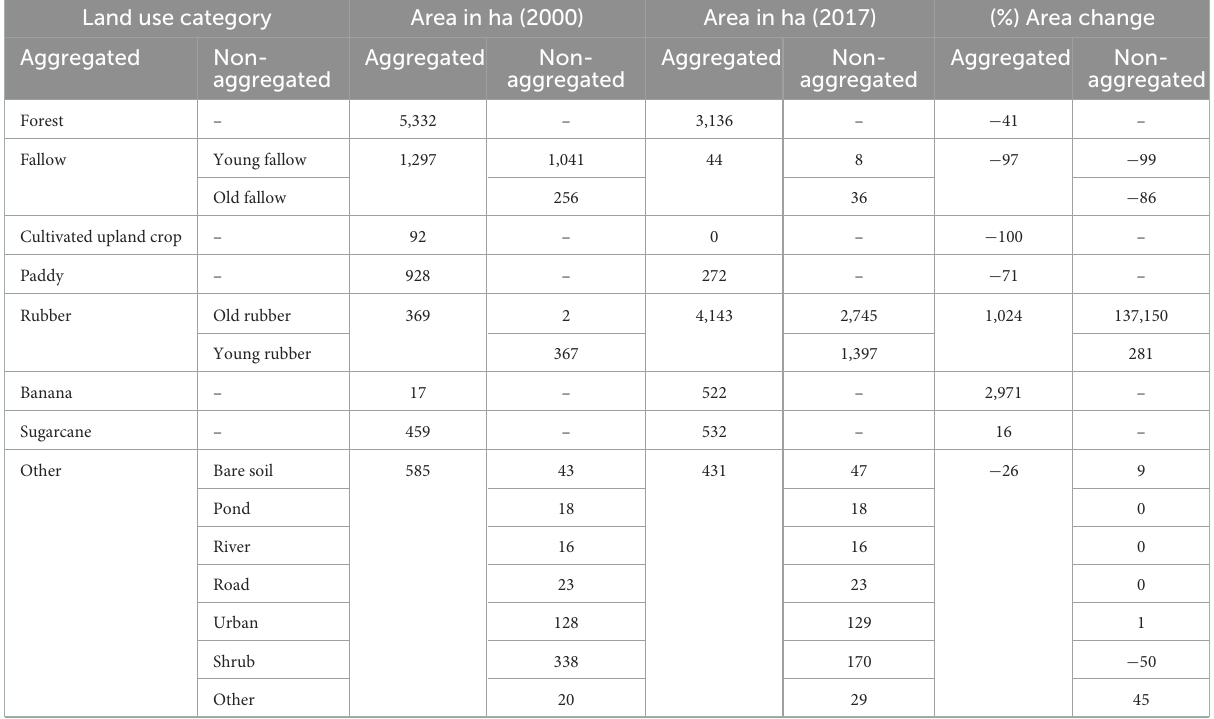
TABLE 3 Land use in the case study landscape in 2000 and 2017 and change in percent of the 2000 area. Land use